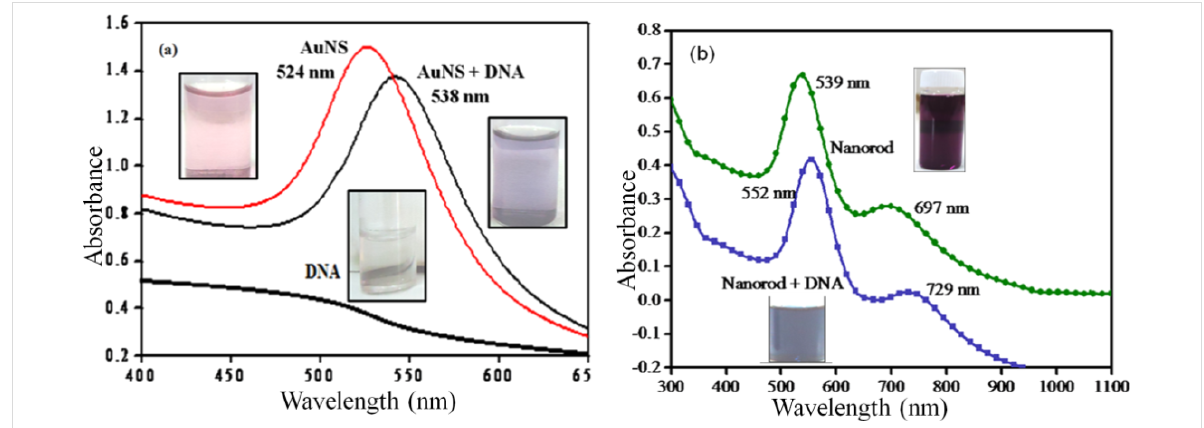
Figure 1: Surface plasmon absorption band of (a) Au nanospheres and (b) Au nanorods before and after DNA modification.